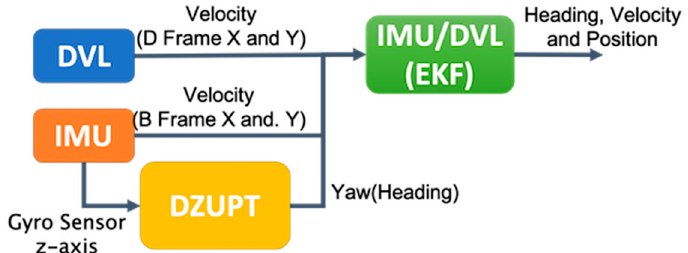
Figure 1. IMU and DVL integration architecture.